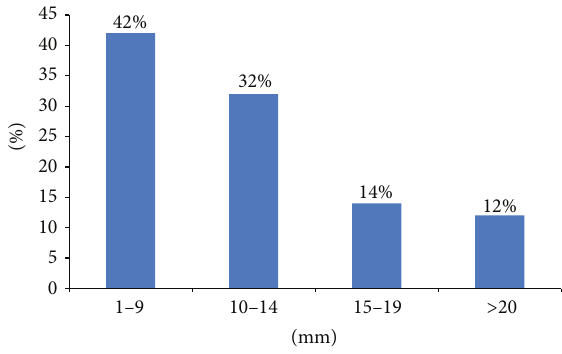
Figure 4: CT scan pneumothorax thickness in